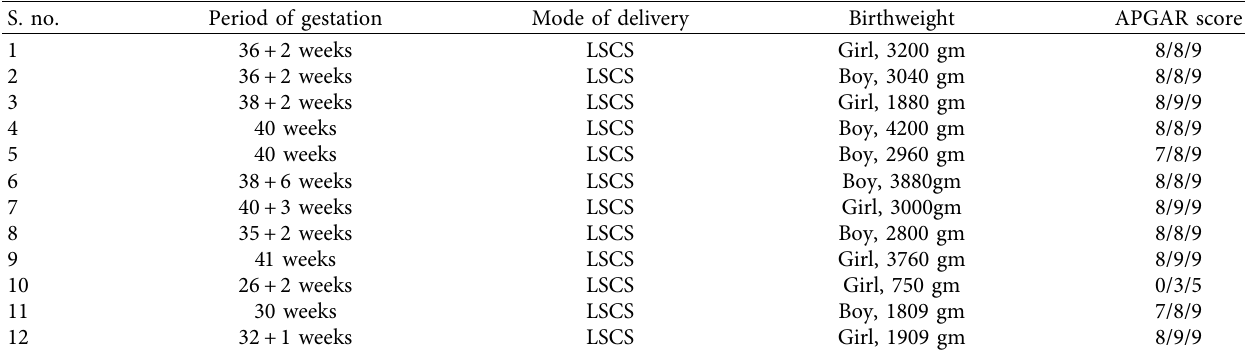
Table 6: Neonatal outcomes of the study group.